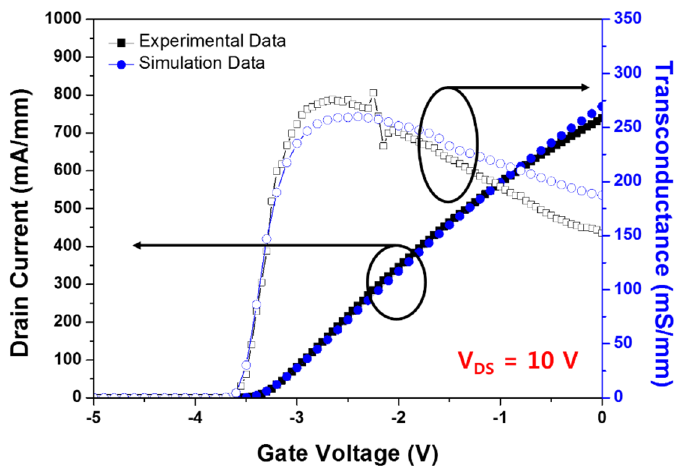
Figure 5. Simulation and experimental data for I-V transfer characteristics considering the self-heating effect (SHE) at V DS = 10 V.